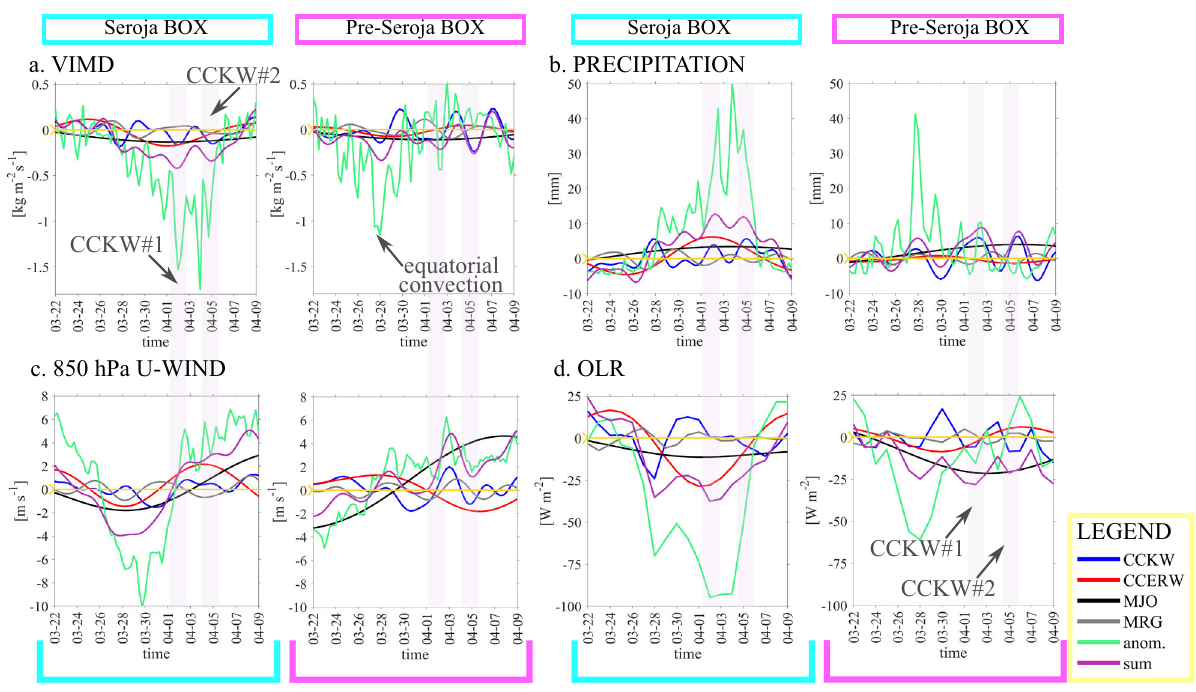
Fig. 5 | Time series at two locations: Pre-Seroja (125 – 132°E, 6°S – 3°N) box and Seroja (120 – 128°E, 15 – 6°S) box for the period of March 22 to April 10, 2021. a 6-hourlyERA-5verticallyintegratedmoisturedivergence(VIMD), b 6-hourlyGPM precipitation, c zonal component of 850hPa wind (U-WIND), and d outgoing longwave radiation (OLR).Color linesindicate Convectively Coupled KelvinWaves